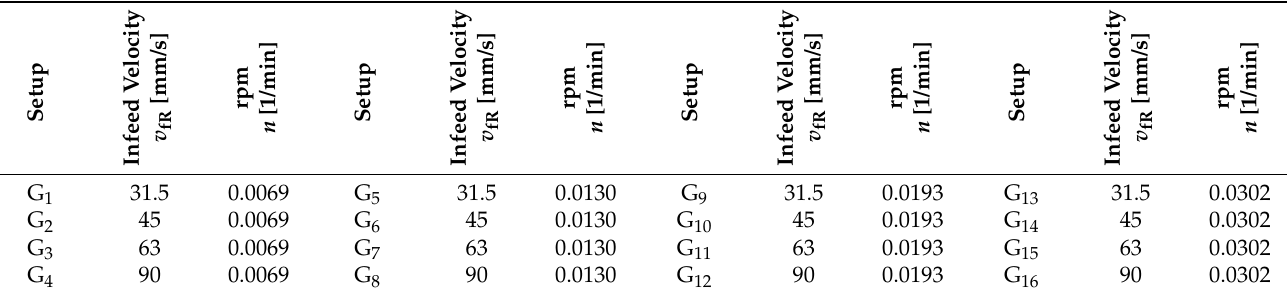
Table 5. Experimental setup and the applied cutting data for